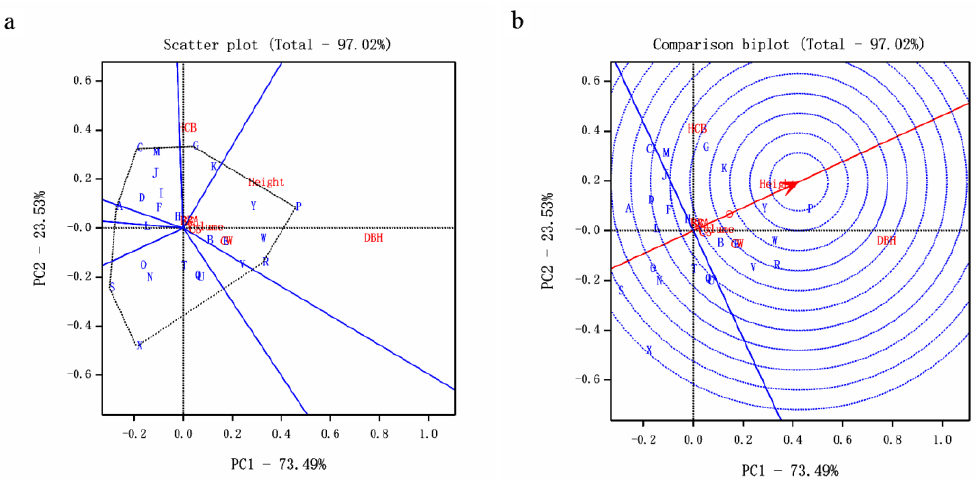
Figure 5. Biplot analysis based on all traits of 25 provenances. ( a ) Polygon view of GGE biplot—which is best for what, ( b ) genotypes of ranking provenances. DBH, diameter at breast height; HCB, height